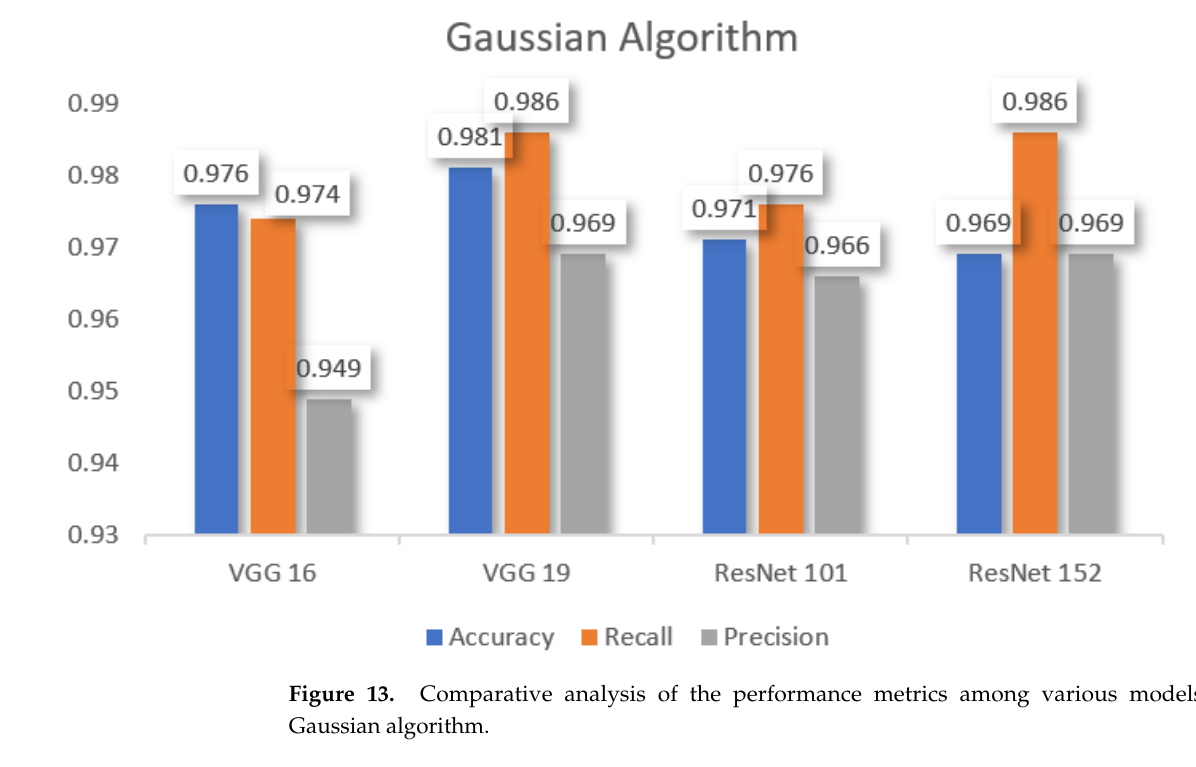
Figure 12. Comparative analysis of the performance metrics among various models using logistic regression.